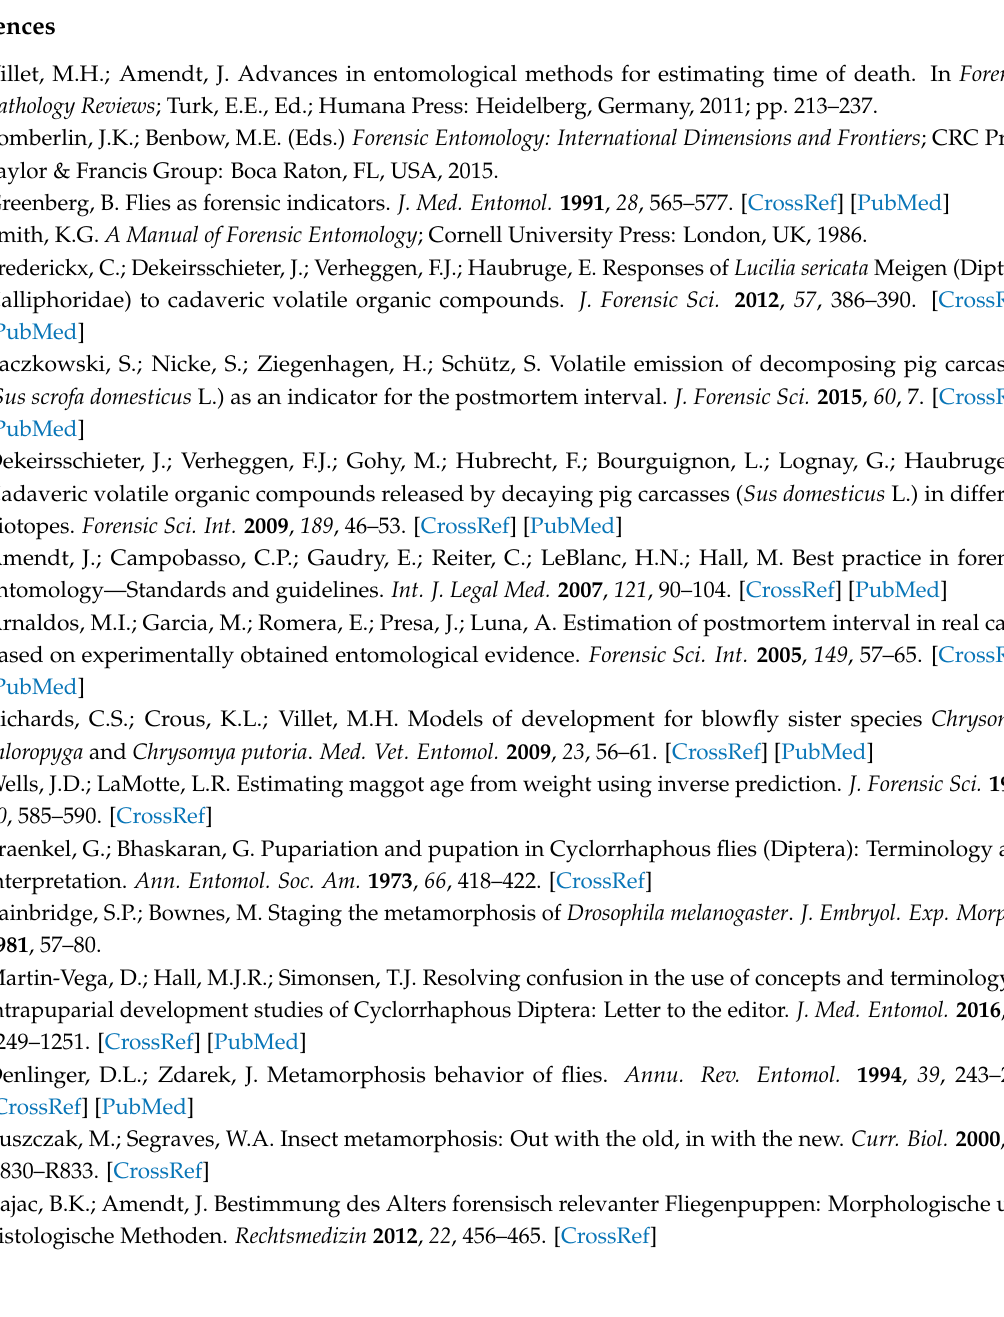
Table S1: Multiple comparison (MC) analysis. Raw data S2: Absolute C T values of all markers at all